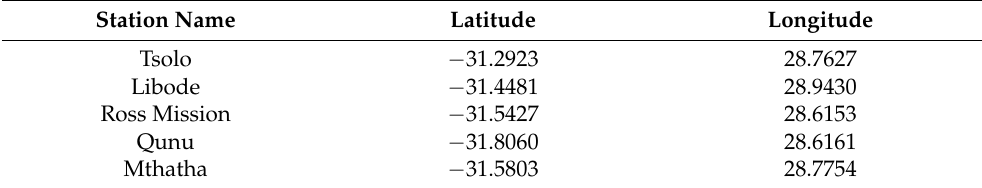
Table 1. Locations of the weather